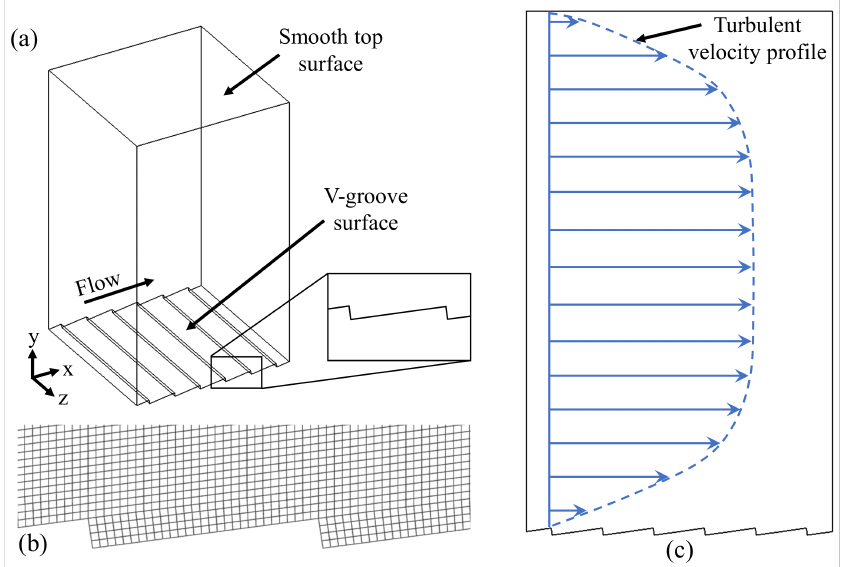
Figure 2. Methodology of numerical simulation of drag performance: ( a ) computational do- main for 8 ◦ case, ( b ) mesh detail near ATR topography, and ( c ) anticipated mean velocity profile through